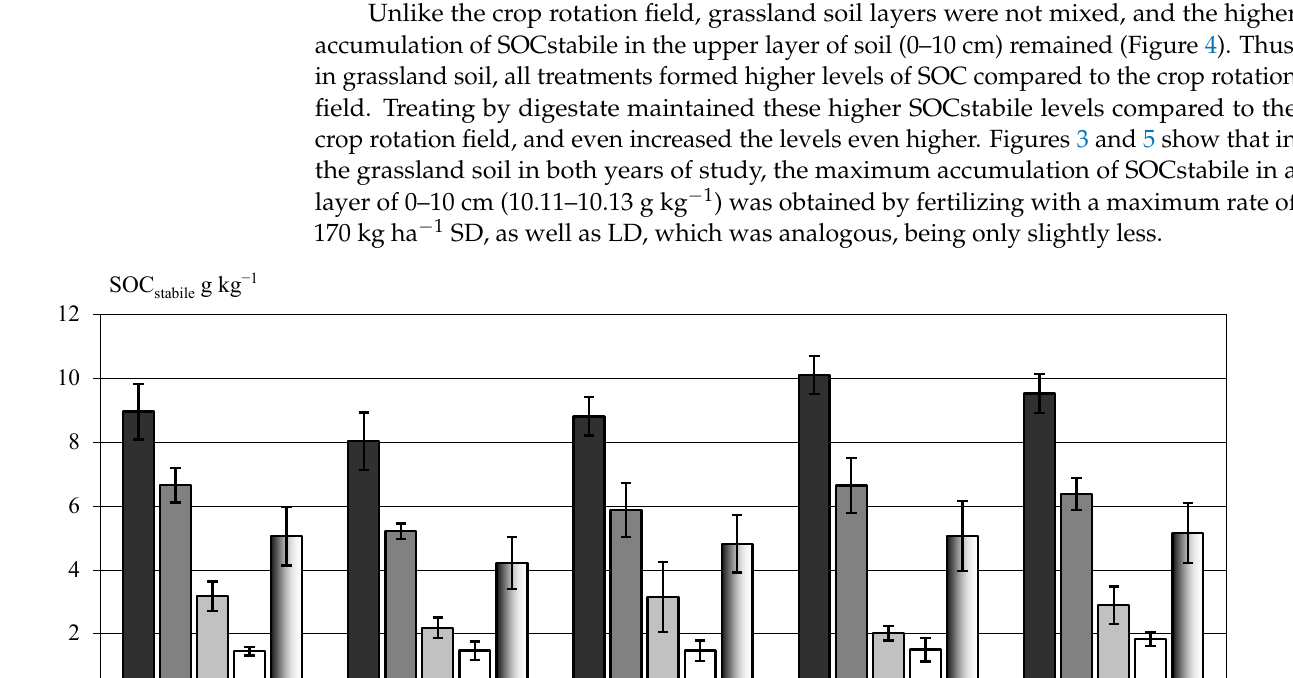
Figure 4. Stabile soil organic carbon (SOCstabile) in crop rotation field treated by digestate, 2020. Vertical bars represent standard error.